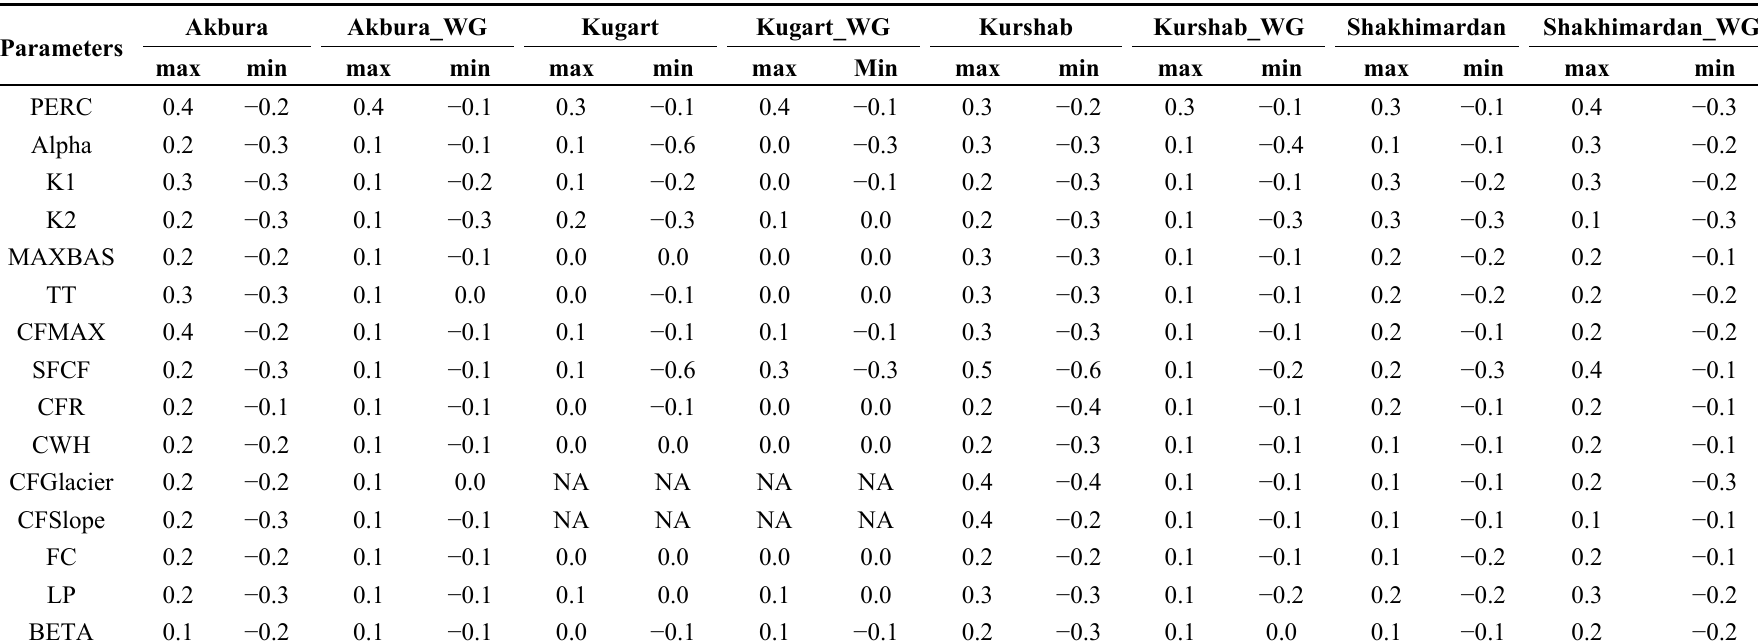
Table 8. The range of correlation coefficients among the parameters generated using the MC method for the studied basins. NA = not available, parameter is only needed for glaciered